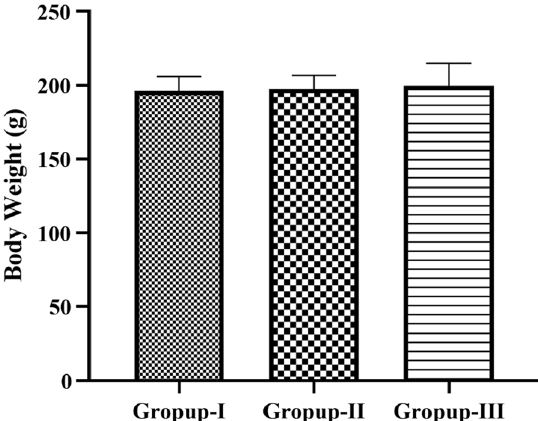
Fig. 1 In the presence and absence of naringenin and verapamil, the transfer of ranolazine from the serosal to mucosal side of the chick-everted ileum ( n 6). R stands for ranolazine, N for naringenin, = and MDS is for multidose